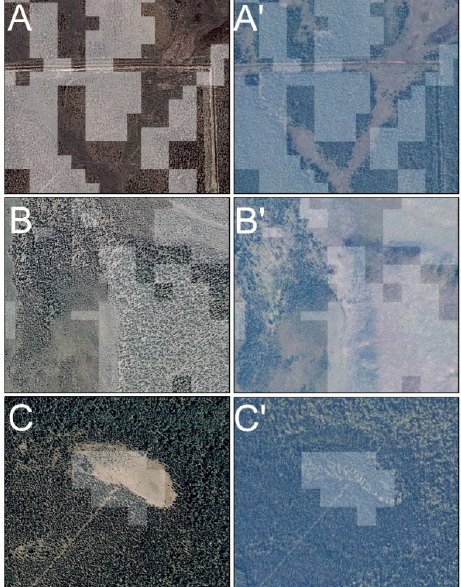
Figure 7. Examples of land-cover transitions between 1973 ( A , B , C ) and 2017 ( A’ , B’ , C’ ). Areas common to each scene and representing detected change are shaded in white. Forests lost to a pre-1973 fire ( A ) regenerate to closed canopy forest by 2017 ( A’ ). Mature forest stands in 1973 ( B ) are lost to fire in 1996 and have not regrown by 2017 ( B’ ). Wetland meadow ( C ) is infilled by woody vegetation possibly due to drying or warming (C’).